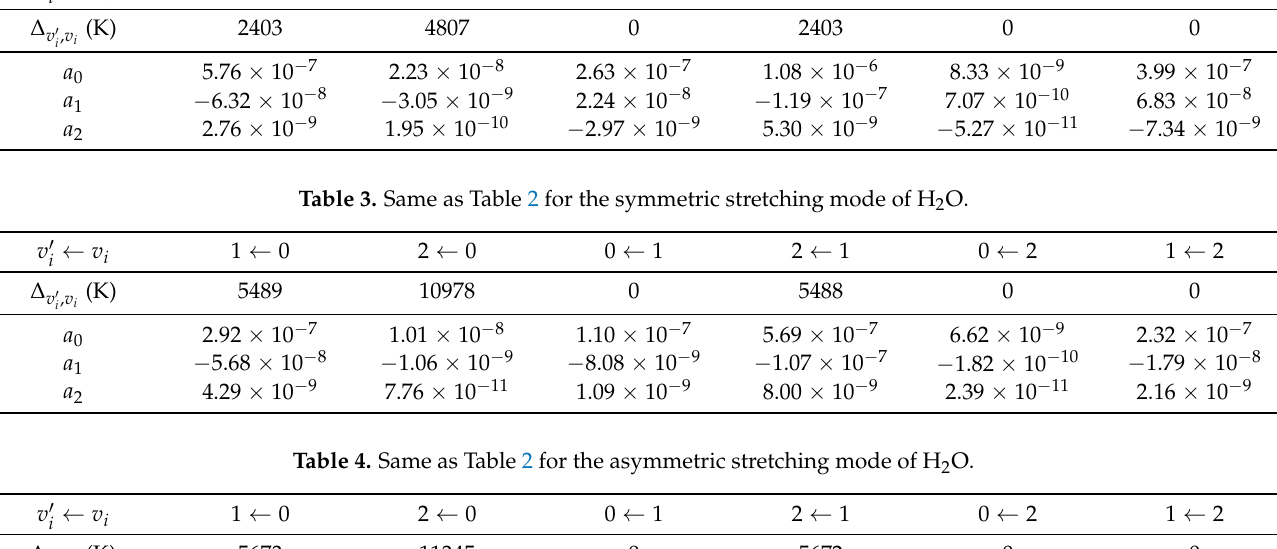
Table 2. Parameters a 0 , a 1 and a 2 of the polynomial P fit states for the bending mode of H 2 O. The pairs of the final and initial vibrational levels for each normal mode are at the second line in each header of the tables. The third line in each header gives the threshold energies ∆ υ